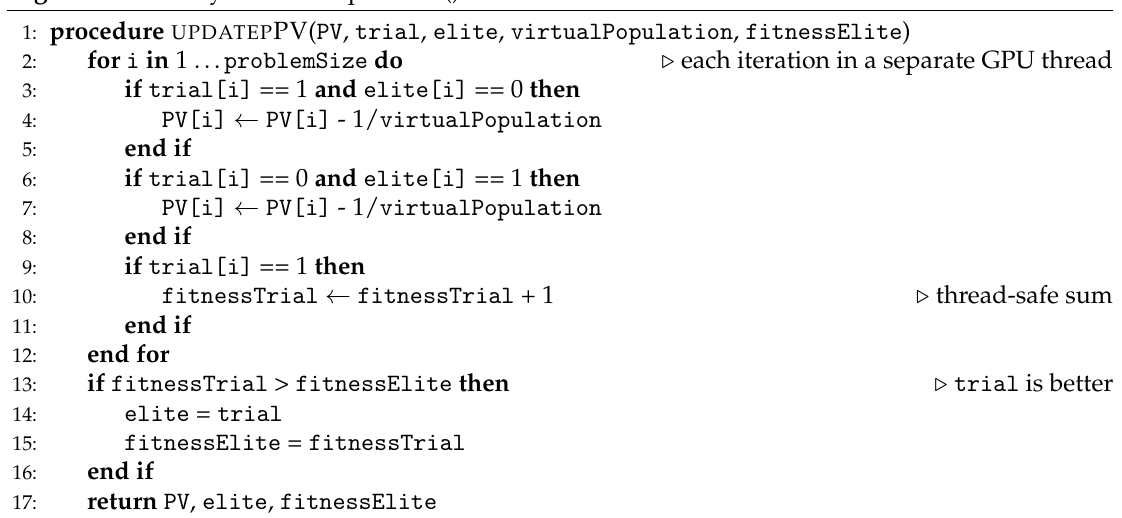
Algorithm 6 Binary cGA-A1: